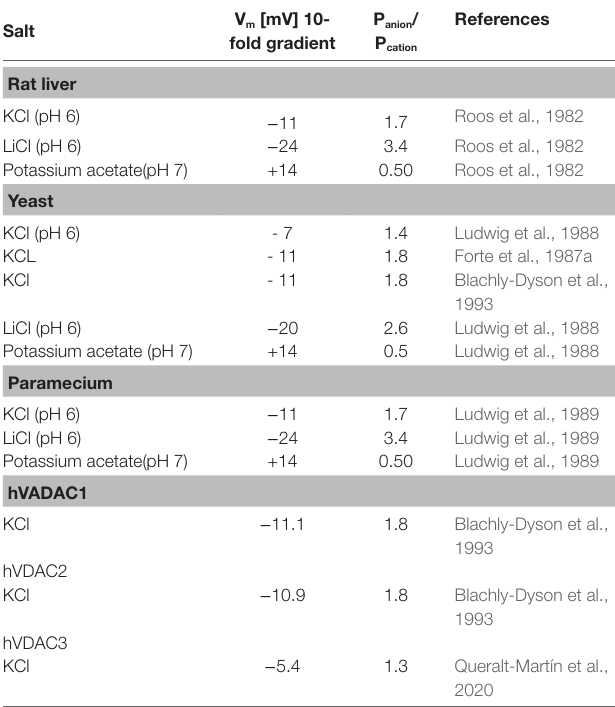
TABLE 2 | Zero-current membrane potentials, V m , of lipid bilayer membranes the presence of rat liver, yeast, human eukaryotic porin1, human eukaryotic porin2, and Paramecium porins measured for 10-fold gradients of different salts. V m is defined as the potential of the dilute side (10 mM/100 mM) relative to that of the